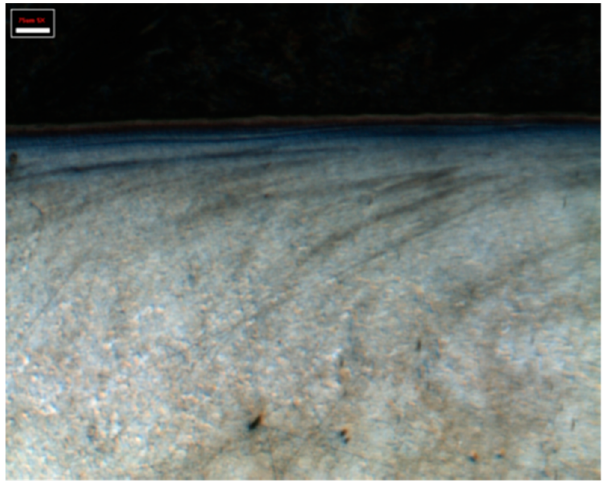
Figure 29. Plastic flow and crack at slip ratio of